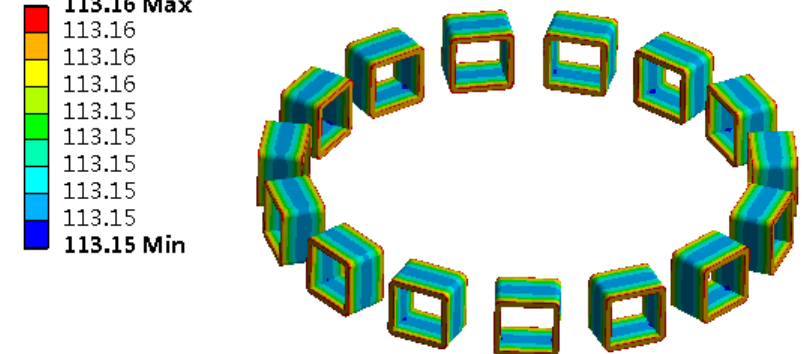
Figure 12. Contour diagram of stator winding temperature.